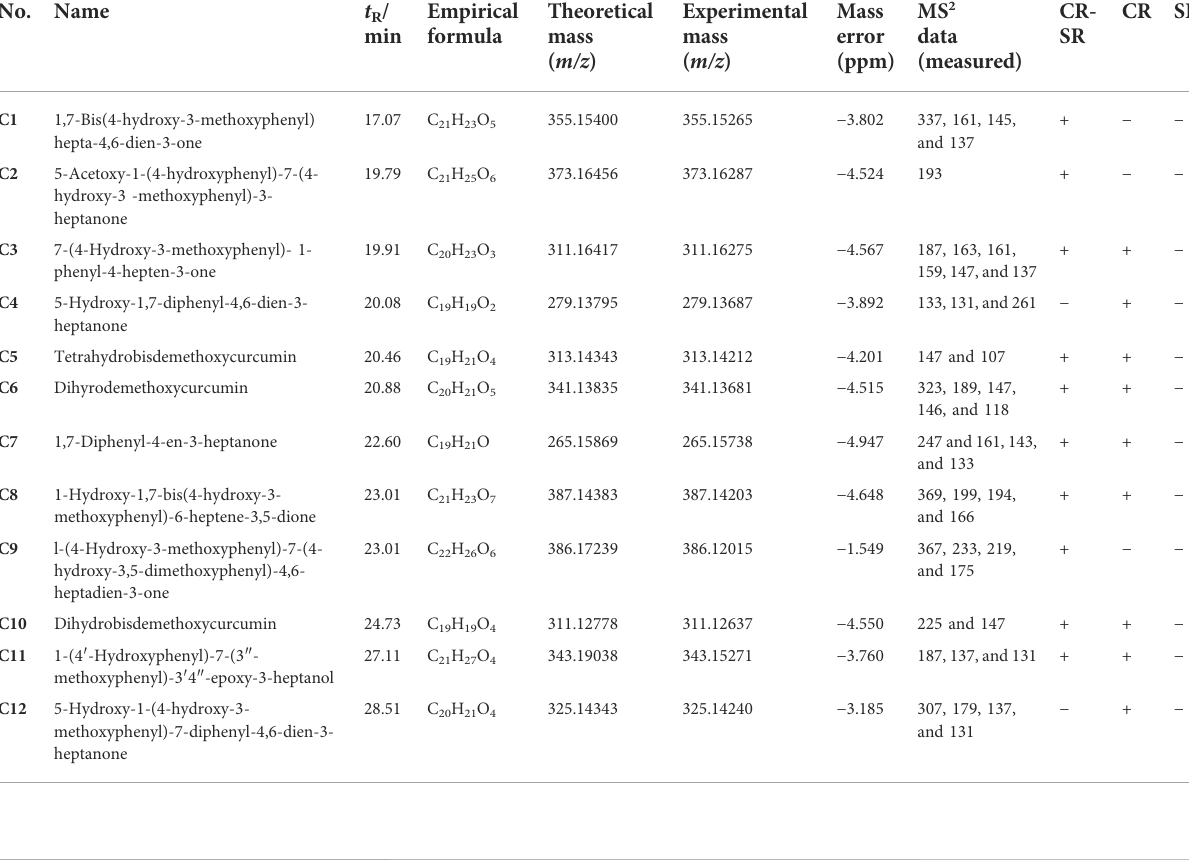
TABLE 2 Identi fi cation of the novel diarylheptanoids of CR-SR and CR decoction by the molecular network.